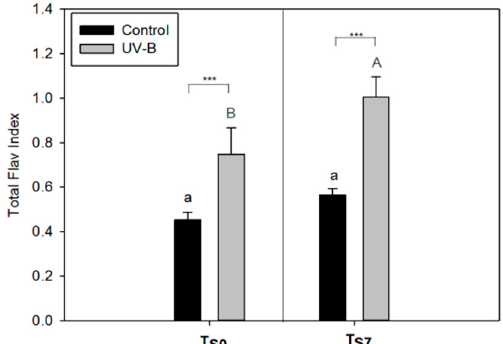
Figure 1. Total Flav Index of leaves of O. basilicum plants cultivated under white light (control—black bars) and supplemental UV-B radiation (UV-B—gray bars) at the end of the light treatment (before storage, T S0 ) and after seven days of storage (T S7 ). Mean ± SD ( n = 3). Letters show the comparison between di ff erent storage times (T S0 or T S7 ) under the same light conditions (uppercase gray letters—UV-B treatment; lowercase black letters—control). Di ff erent letters indicate significant di ff erences between the values ( p < 0.05), while asterisks show the significant di ff erence between light treatments at the same time of storage (*** p ≤ 0.001); ns = not significant.